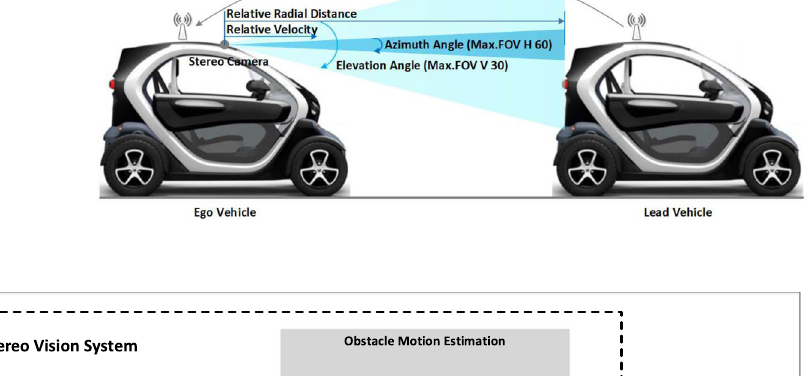
Fig. 4 System overview of the stereo vision system in vehicle platooning